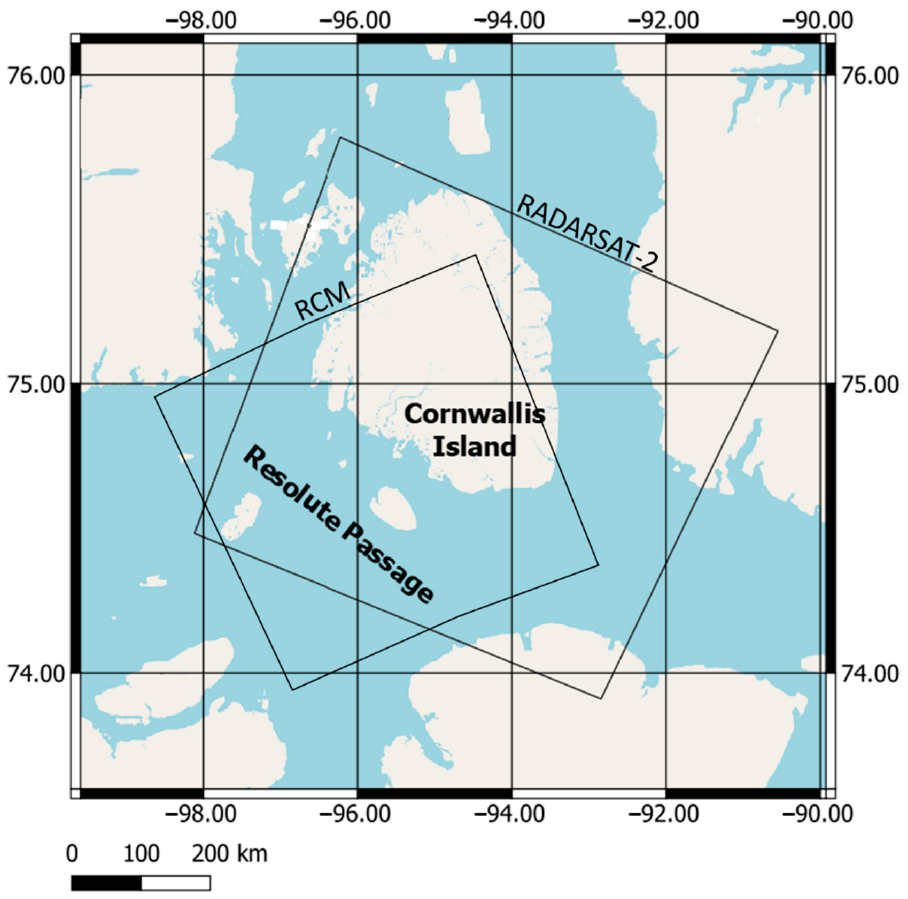
Figure 2. RADARSAT-2 and RCM acquisitions over the Resolute Passage, Canadian Central Arctic.